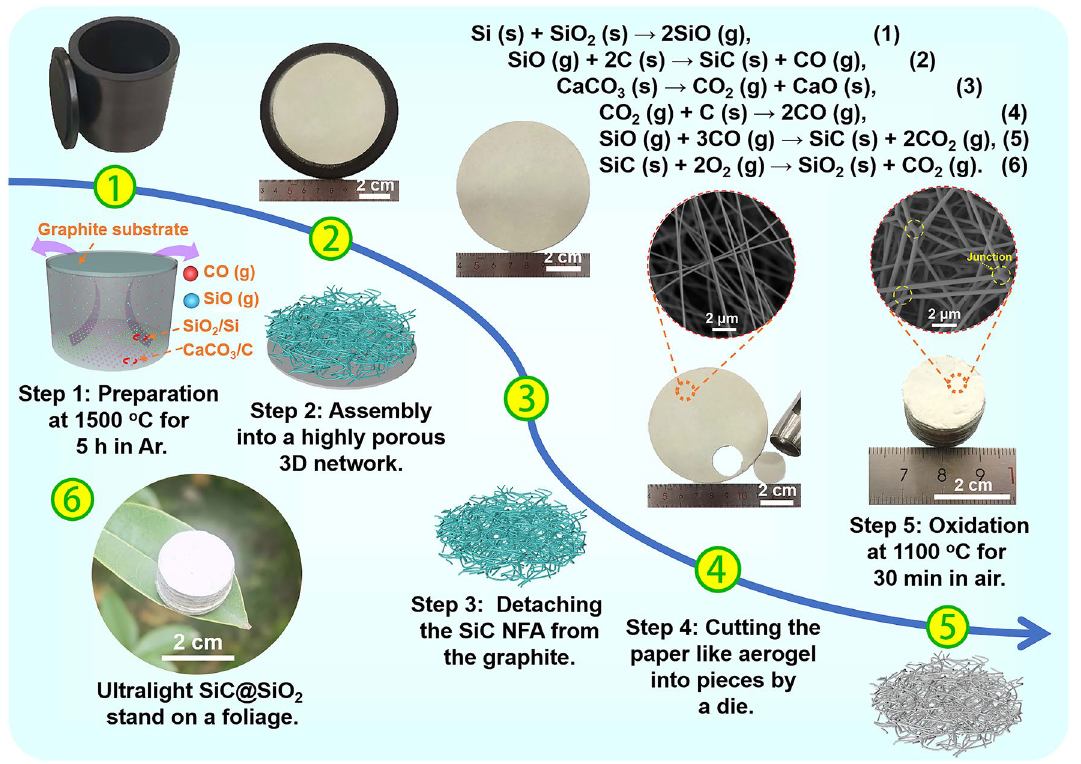
Fig. 1 Preparation process for the SiC@SiO 2 NFA. ① Step 1: Preparation at 1500 °C for 5 h in Ar. ② Step 2: The self-assembly into a 3D highly porous aerogel. ③ Step 3: Detachment of the SiC NFA from the graphite lid at 700 °C for 2 h in air. ④ Step 4: The aerogels are punched into cir- cular tablets with a diameter of 2 cm. ⑤ Oxidation of SiC NFA to form stable cross-linking junctions at 1100 °C for 30 min in air and SiO 2 coat- ing on each nanofiber, marked as